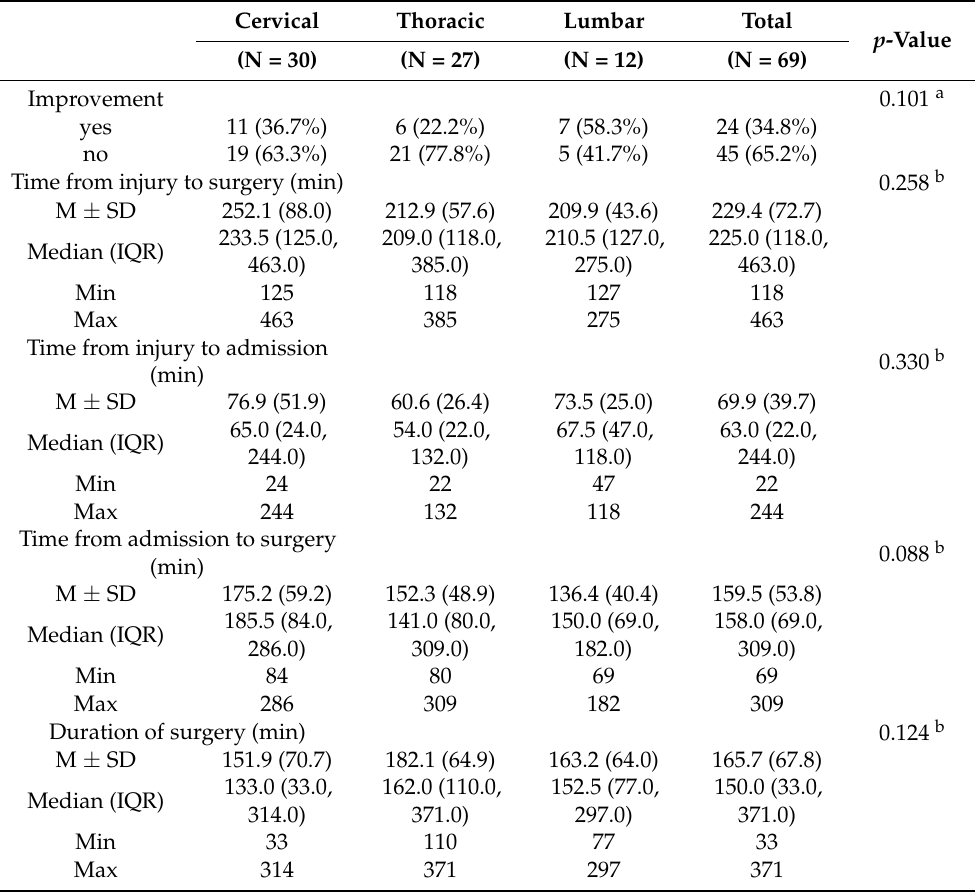
Table 3. Timing descriptions in NLI